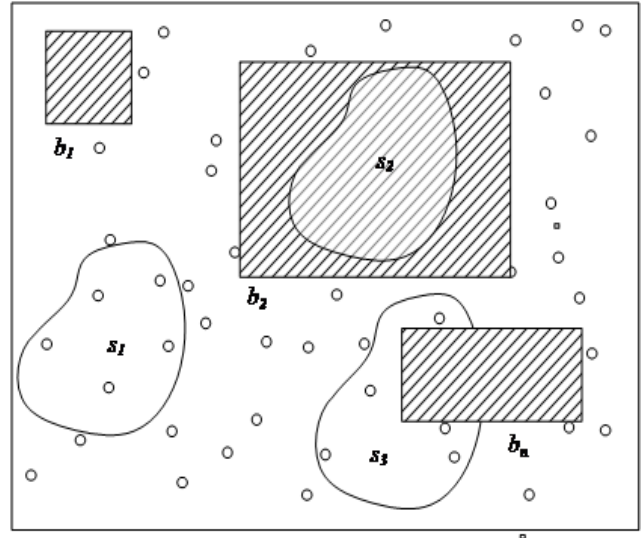
Figure 1. Users’ distribution in the service